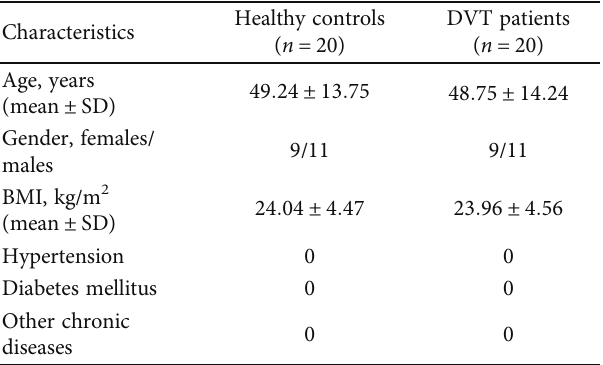
Table 3: Baseline characteristics of DVT patients and healthy